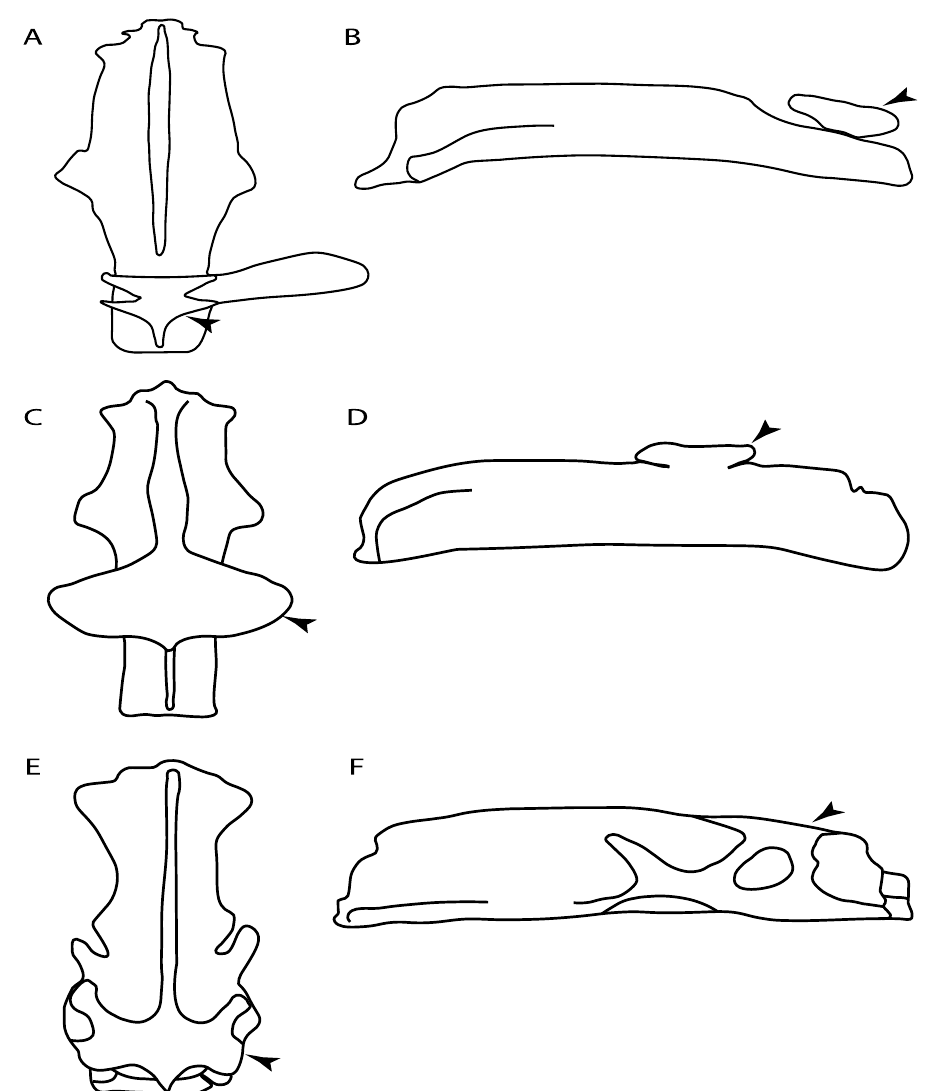
Figure 31. Dorsal and lateral view of synarcual and suprascapula. Interpretative drawing of: State (0): ( A , B ) Trygonorrhina sp. (Uncatalogued) redrawn and modified from Claeson Text-Figure 5.16A in [71]. State (1): ( C , D ) Beringraja pulchra redrawn and modified from Nishida Text-Figure 39C in [82]. State (2): ( E , F ) Myliobatis tobijei redrawn and modified from Nishida Text-Figure 38H in [82]. Arrowheads: suprascapula.